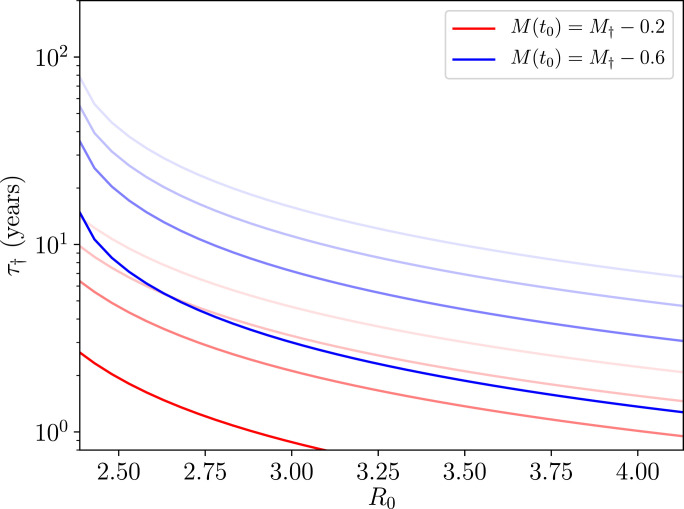
Numerically-obtained values using integral in Eq. (21) to compute the length of time it takes for the transmission dynamics to reach the value of M=M†(z,k) for two different initial values of M=M(t0), as shown in the legend. A range of worm death rates have been used of μ1=1/2years−1,1/5years−1,1/8years−1,1/12years−1 in decreasing order, which corresponds to a fading colour in the plotted lines.